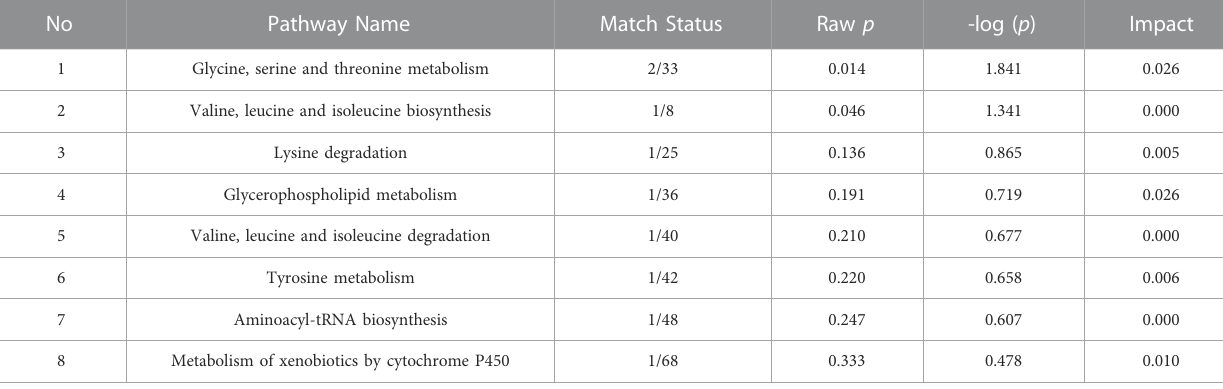
TABLE 6 Analysis of metabolic pathways in urine based on potential biomarkers